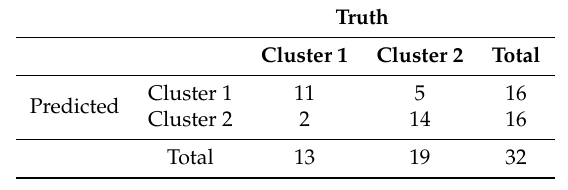
Table 2. Confusion matrix for the k-means clustering model.